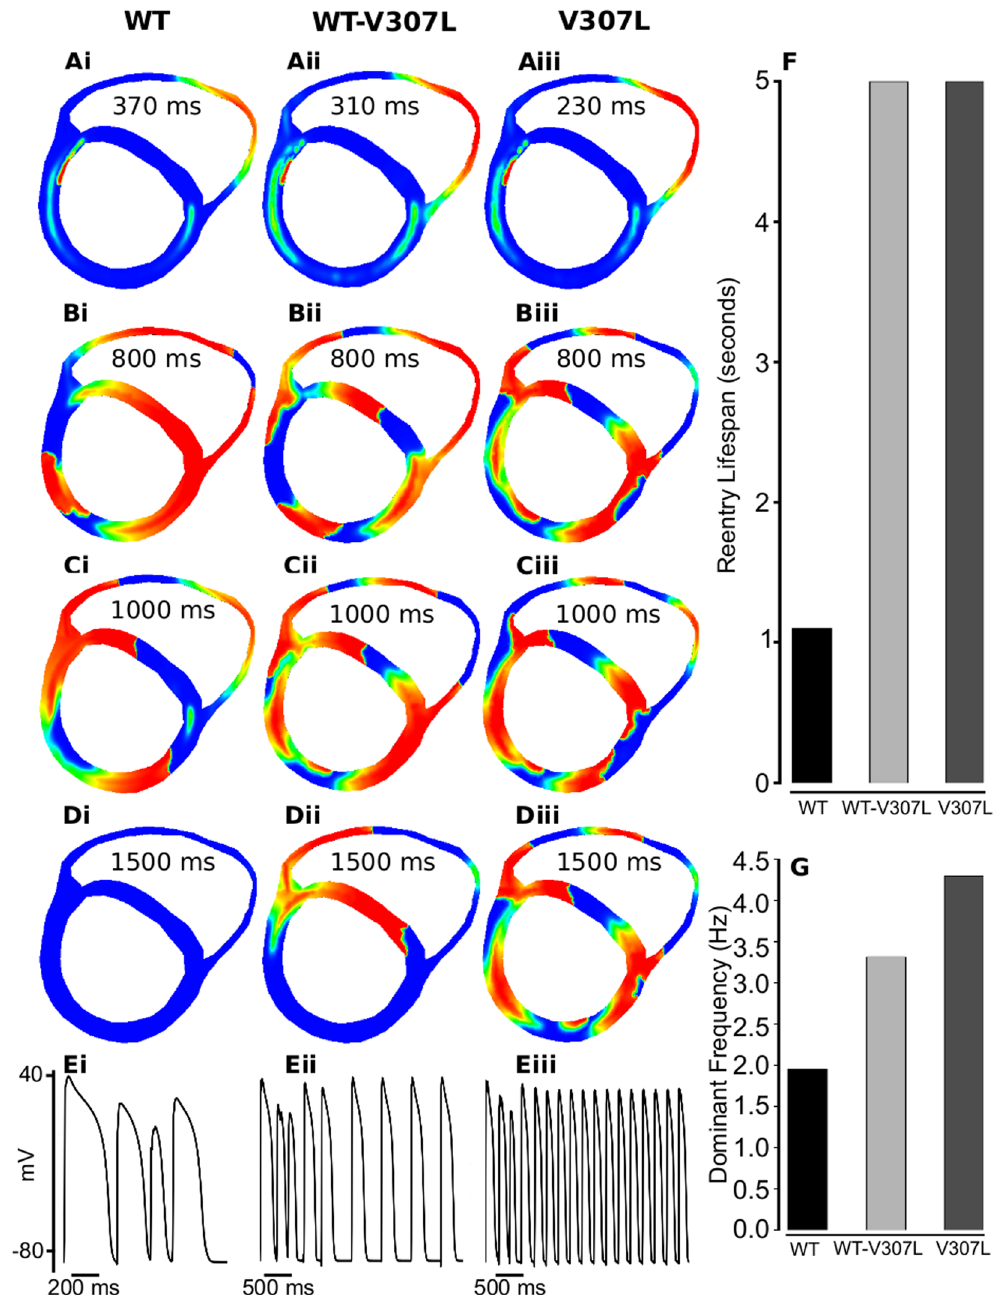
Figure 5. Snapshots of re-entry in 2D cross-section of ventricles. ( A ) Application of a premature S2 stimulus into the refractory and partially recovered tissue following excitation after a delay of 370 ms for WT (i), 310 ms for WT-V307L (ii), and 230 ms for V307L (iii) conditions. Snapshots of developed spiral waves at time, t = 800 ms ( B ), t = 1000 ms ( C ), and t = 1500 ms ( D ) in WT (i), WT-V307L (ii), and V307L (iii) conditions. ( E ) Time series of cellular APs recorded in the left ventricle in WT (i), WT-V307L (ii), and V307L (iii) conditions. Measured lifespan ( F ) and dominant frequency ( G ) of re-entrant spiral waves. Computed dominant frequencies are 1.96 Hz, 3.32 Hz, and 4.30 Hz for WT, WT-V307L, and V307L conditions,